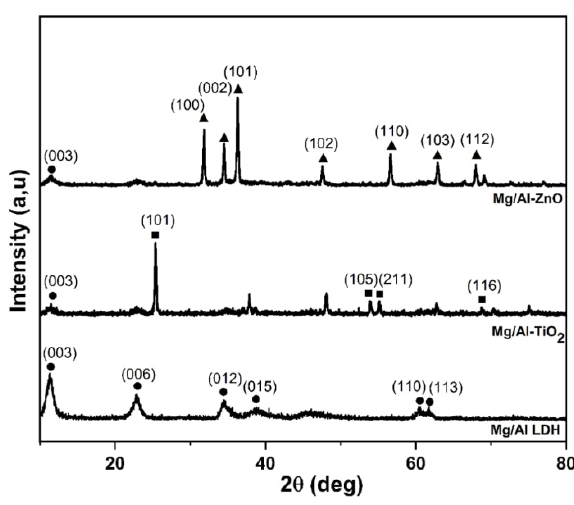
Fig. 8. Diffractogram of catalyst material after 5 th regeneration cycles